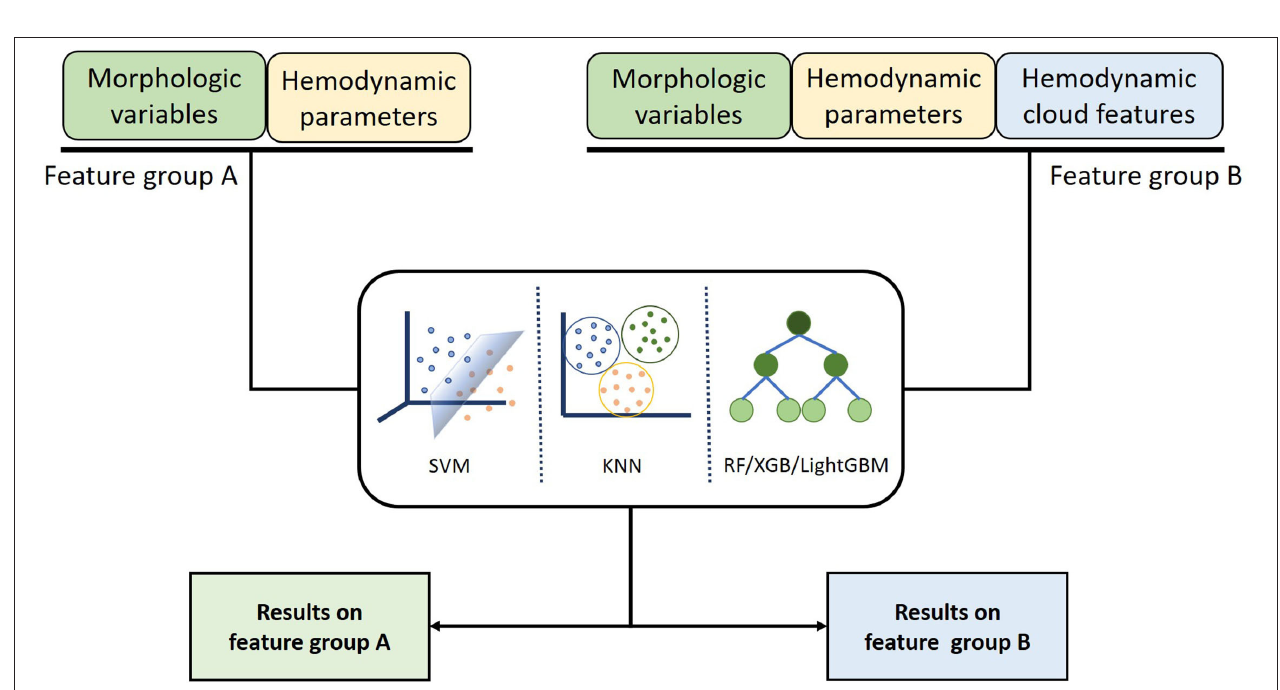
FIGURE 6 | Classification models inputting different features were established using machine learning algorithm to compare the influence of different features on classification results.